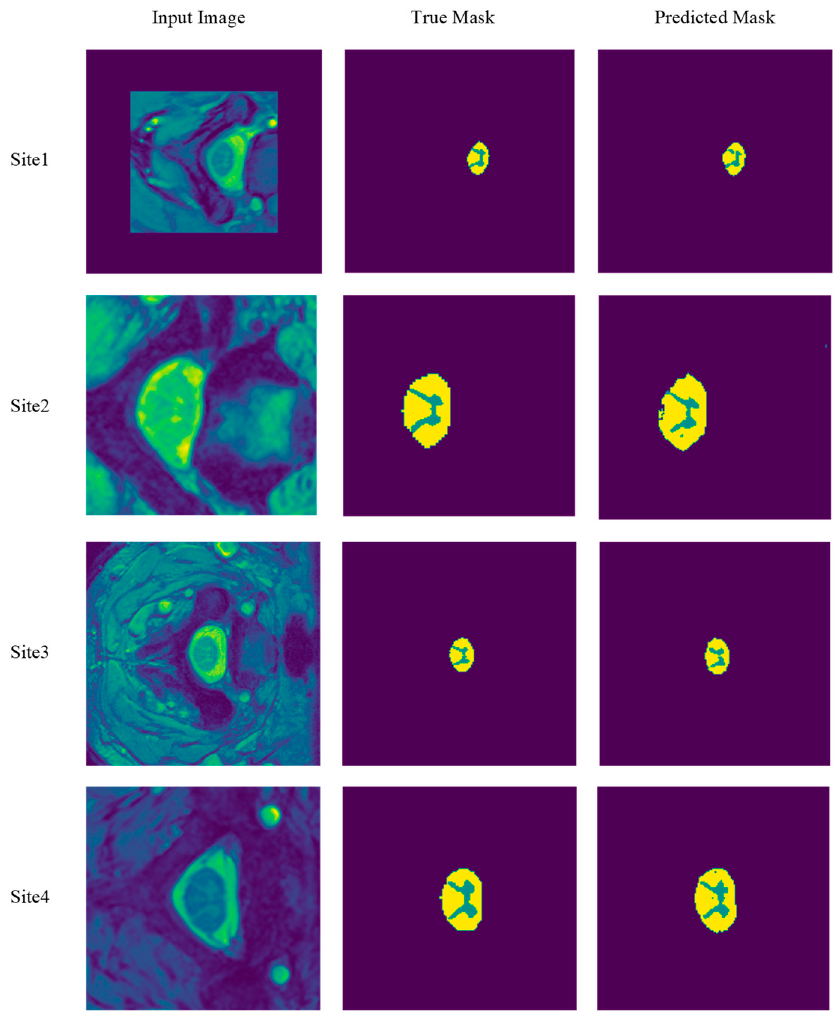
Figure 19. Segmentation results of four MRI slices from the four previously mentioned sites. The following slices are selected from sites 1, 2, 3, and 4, respectively: Slice 1 from subject 15, slice 13 from subject 11, slice 6 from subject 15, and slice 1 from subject 11. The RMSProp optimizer, a batch size of 8, and 400 epochs are employed with MobileUNetV3 in this set of experiments. Table 7. Comparison of MobileUNetV3 with seven state-of-the-art methods on the basis of five seg- mentation metrics. All eight methods were applied in the segmentation of spinal cord gray matter using the same dataset from the SCGM segmentation challenge. The RMSProp optimizer, 400 epochs, and a batch size of 8 were adopted in the experimental runs of our proposed model. DSC and JI stands for dice similarity coefficient and Jaccard index, respectively.